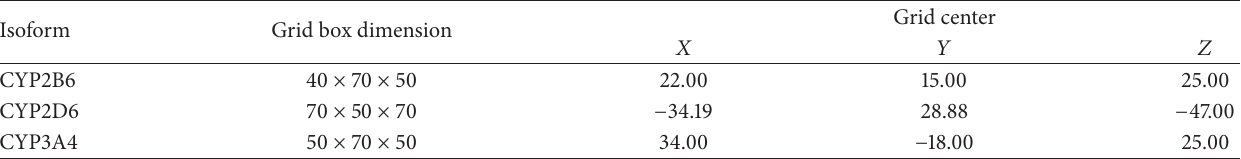
Table 1: Grid box and grid center for CYP2B6, CYP2D6, and